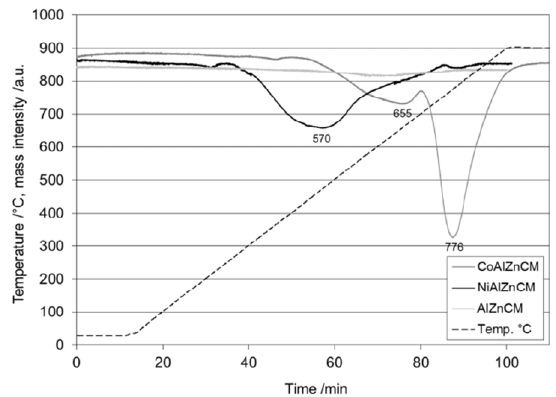
Figure 4. TPR profiles of the catalysts prepared by the citrate method: solid line – H2 signal, dotted line – tempera-